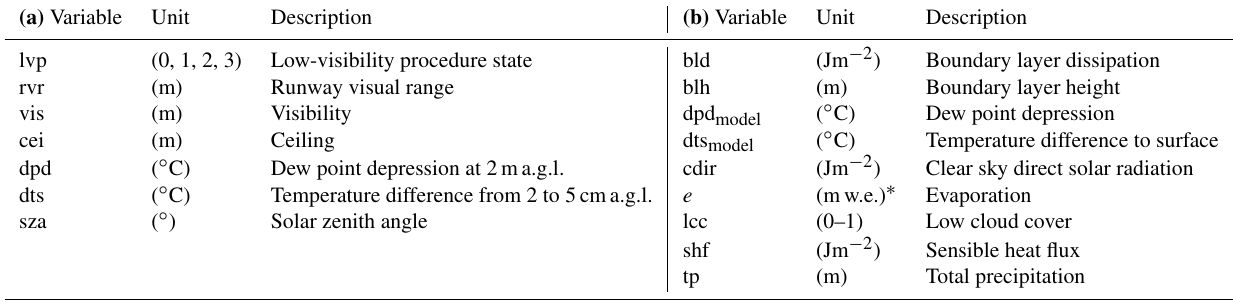
Table 2. Observations, climatological information (a) , and NWP model output (b) used as predictors for the statistical models. The particular predictors from the ENS consist of the mean and standard deviation of all